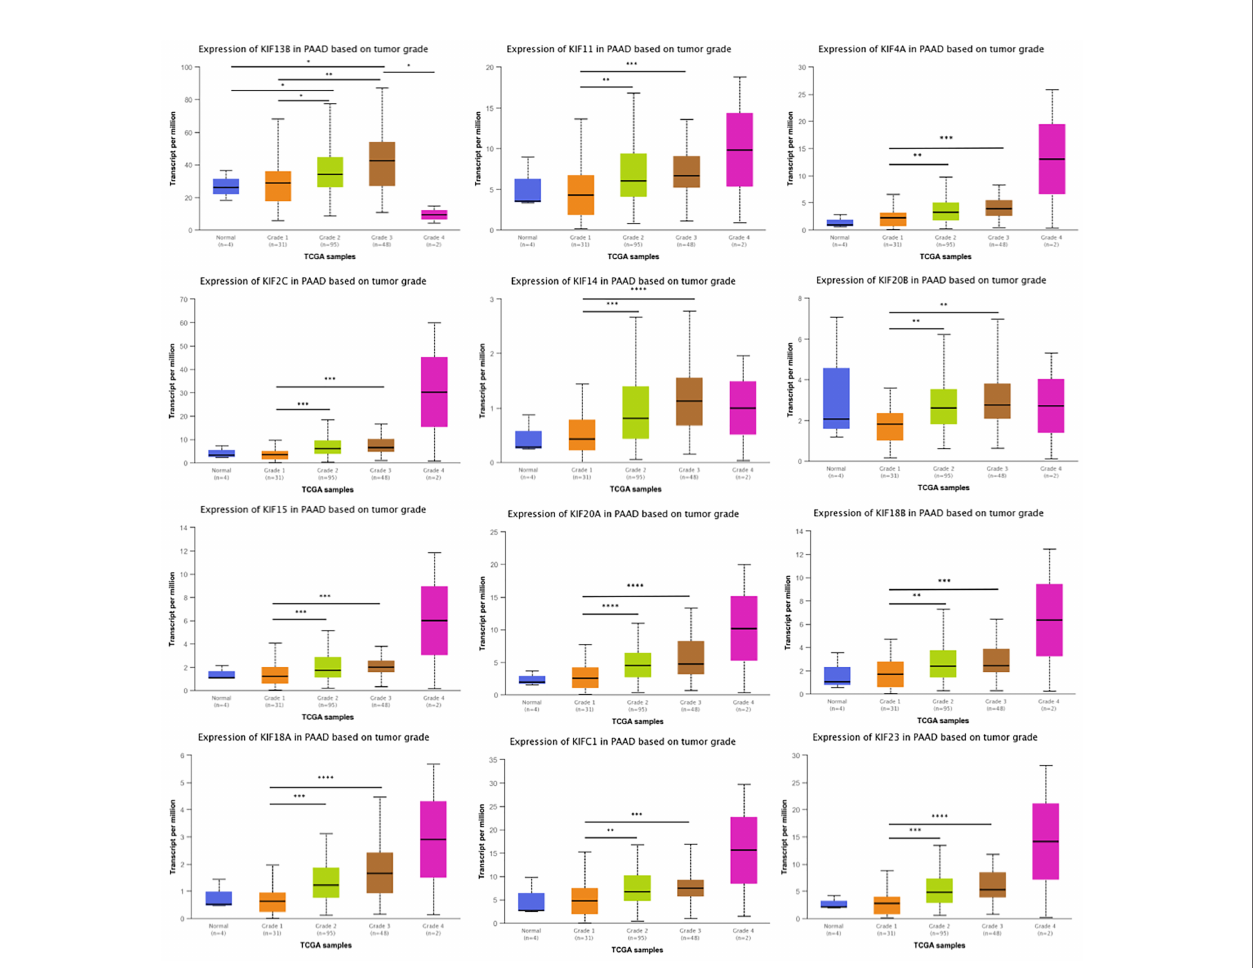
FIGURE 3 | Correlation between prognosis associated KIFs expression and tumor grade in PDAC patients (UALCAN). With the increase in the KIFs mRNA expression, their tumor grade tended to be higher. The correlation between KIF2C, KIF4A, KIF11, KIF14, KIF15, KIF18A, KIF18B, KIF20A, KIF20B, KIF21B, KIF23, and KIFC1 and tumor grade in PDAC patients. *p < 0.05; **p < 0.01; ***p < 0.001; ****p <